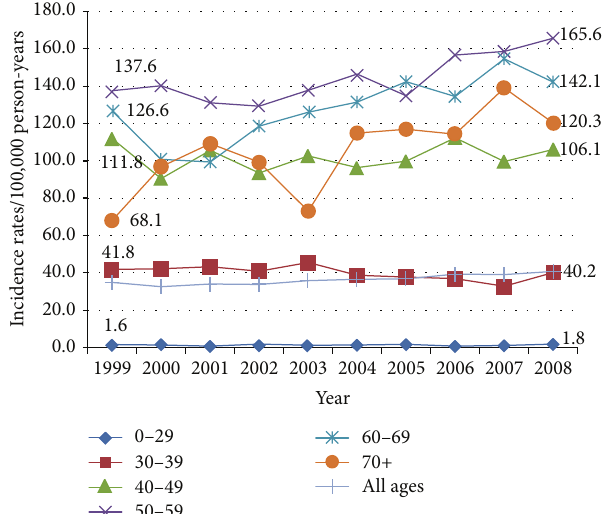
Figure 1: Breast cancer incidence rates/100,000 person-years by age group and year of diagnosis, 1999–2008.